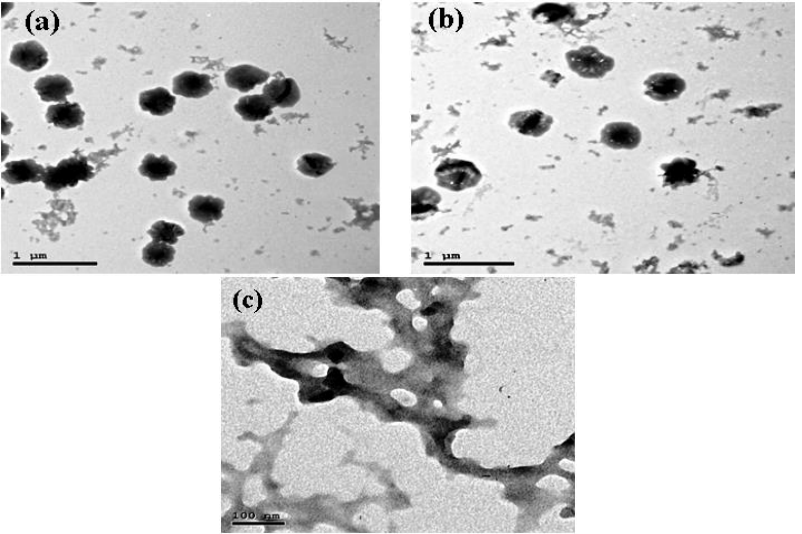
Figure 4. Morphology of chitosan nanoparticles visualized by transmission electron microscopy. The scale bars correspond to 1 μ m ( a , b ), 100 nm ( c ).